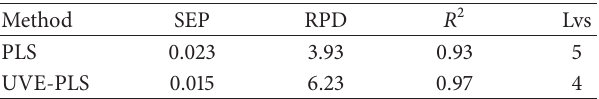
Table 1: Performance comparison of the optimal quantitative PLS and UVE-PLS